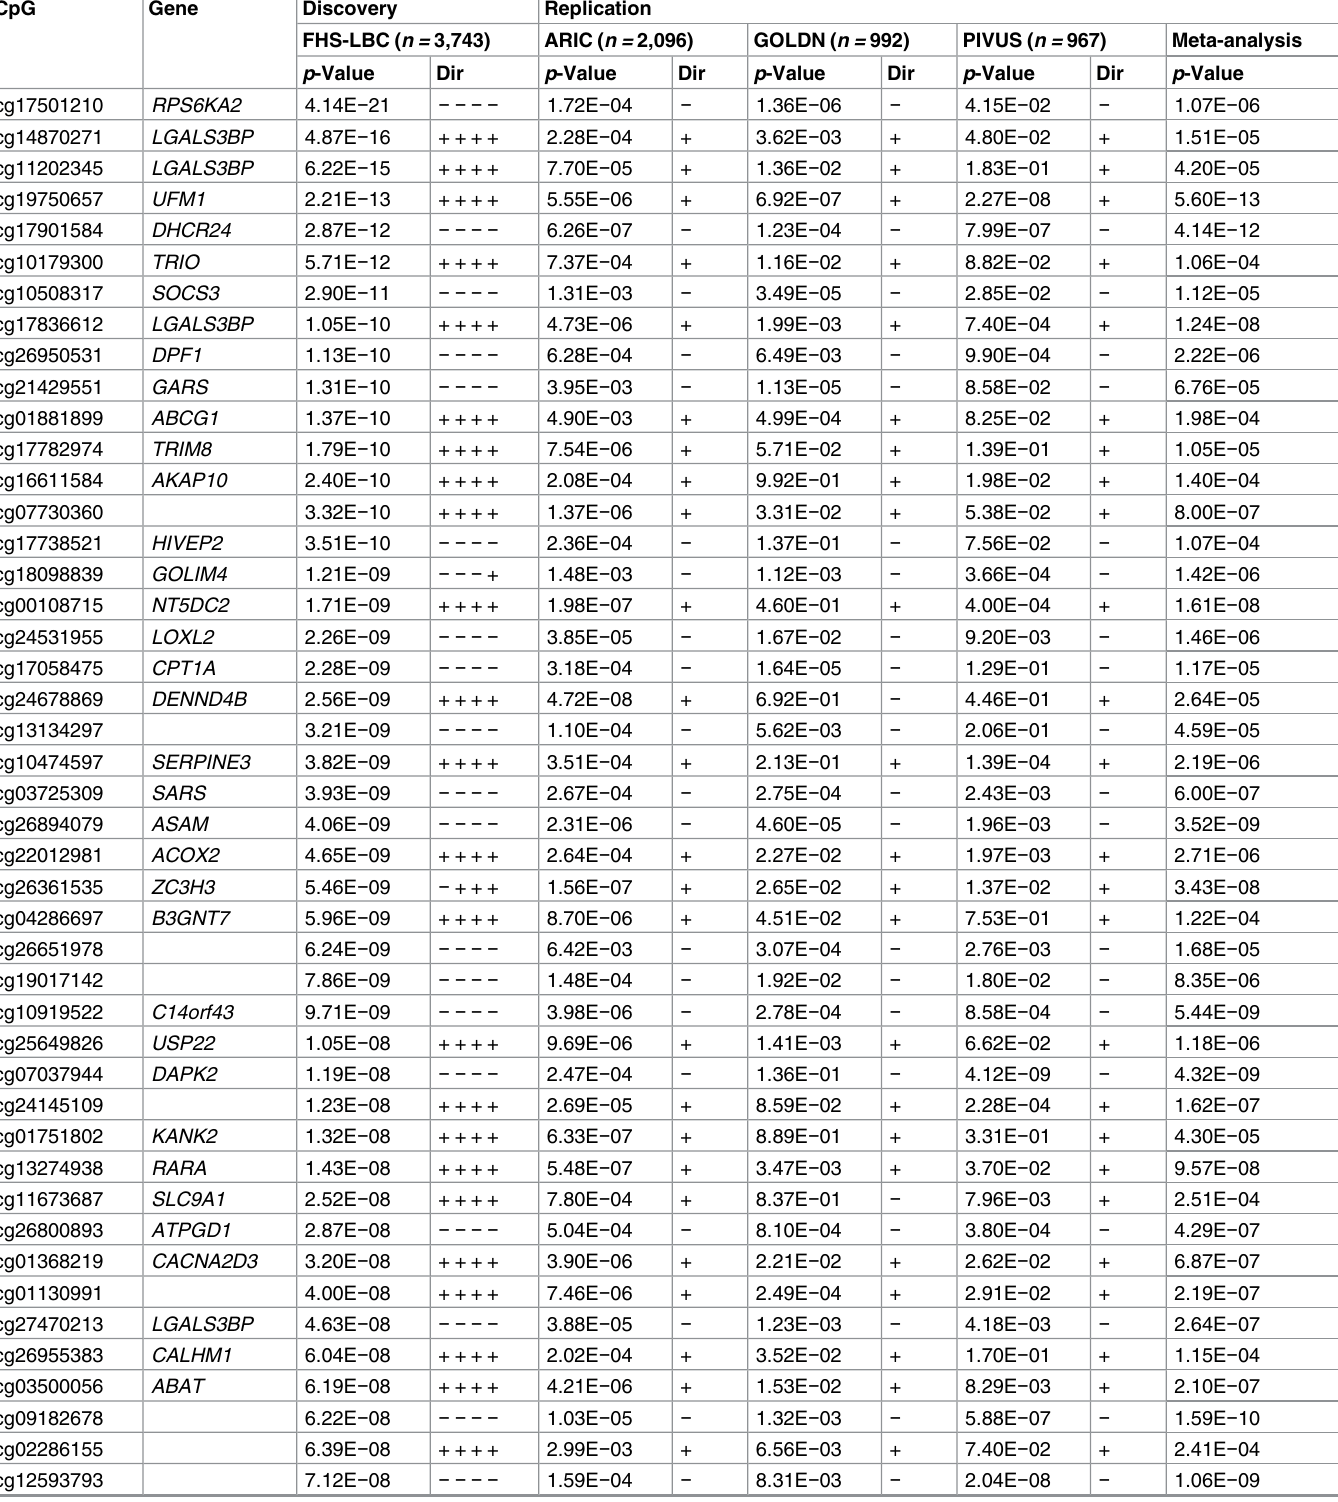
Table 3. Fifty novel replicated differentially methylatedCpGs associated with BMI sorted by p- value in the discovery cohorts. CpG